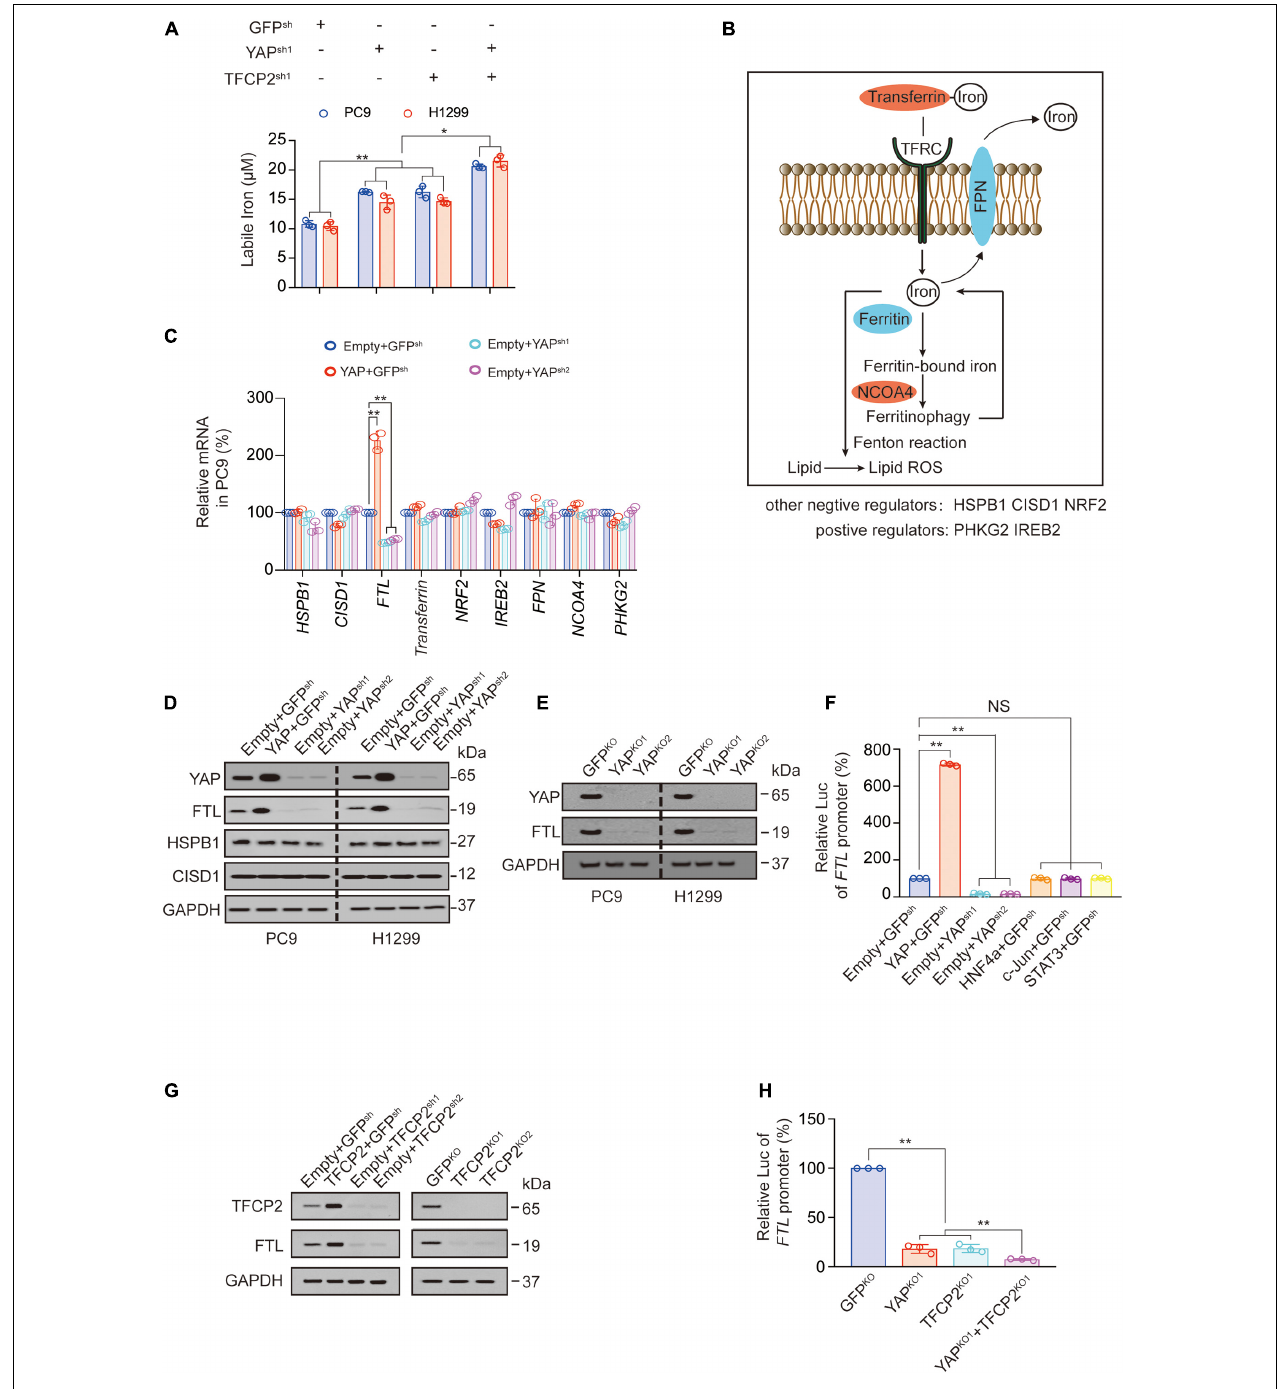
FIGURE 2 | YAP and TFCP2 suppression upregulates labile iron through inhibiting FTL. (A) Labile iron was measured in control cells and PC9 or H1299 cells with YAP and TFCP2 individually or simultaneously knocked out. (B) Schematic representation of pathways and regulators that affect ferroptosis via labile iron levels. (C) The indicated mRNA levels measured in control cells and PC9 cells with YAP overexpression or knockdown. (D) YAP, FTL, HSPB1, and CISD1 expressions were measured using the indicated antibodies in control cells and PC9 or H1299 cells with YAP overexpression or knockdown. (E) YAP and FTL expressions measured using the indicated antibodies in control cells and PC9 or H1299 cells with YAP knockout. (F) FTL promoter luciferase (Luc) activity measured in control cells and PC9 cells with the indicated genes overexpression or knockdown. (G) TFCP2 and FTL expressions measured using the indicated antibodies in control cells and PC9 cells with TFCP2 overexpression, knockdown or knockout. (H) FTL promoter Luc activity measured in control cells and PC9 cells with YAP and TFCP2 individually or simultaneously knocked out. The data are shown as the mean ± SD from three biological replicates (including IB). * P < 0.05, ** P < 0.01 indicates statistical significance. Data in (A,C,F,H) were analyzed using a one-way ANOVA test.